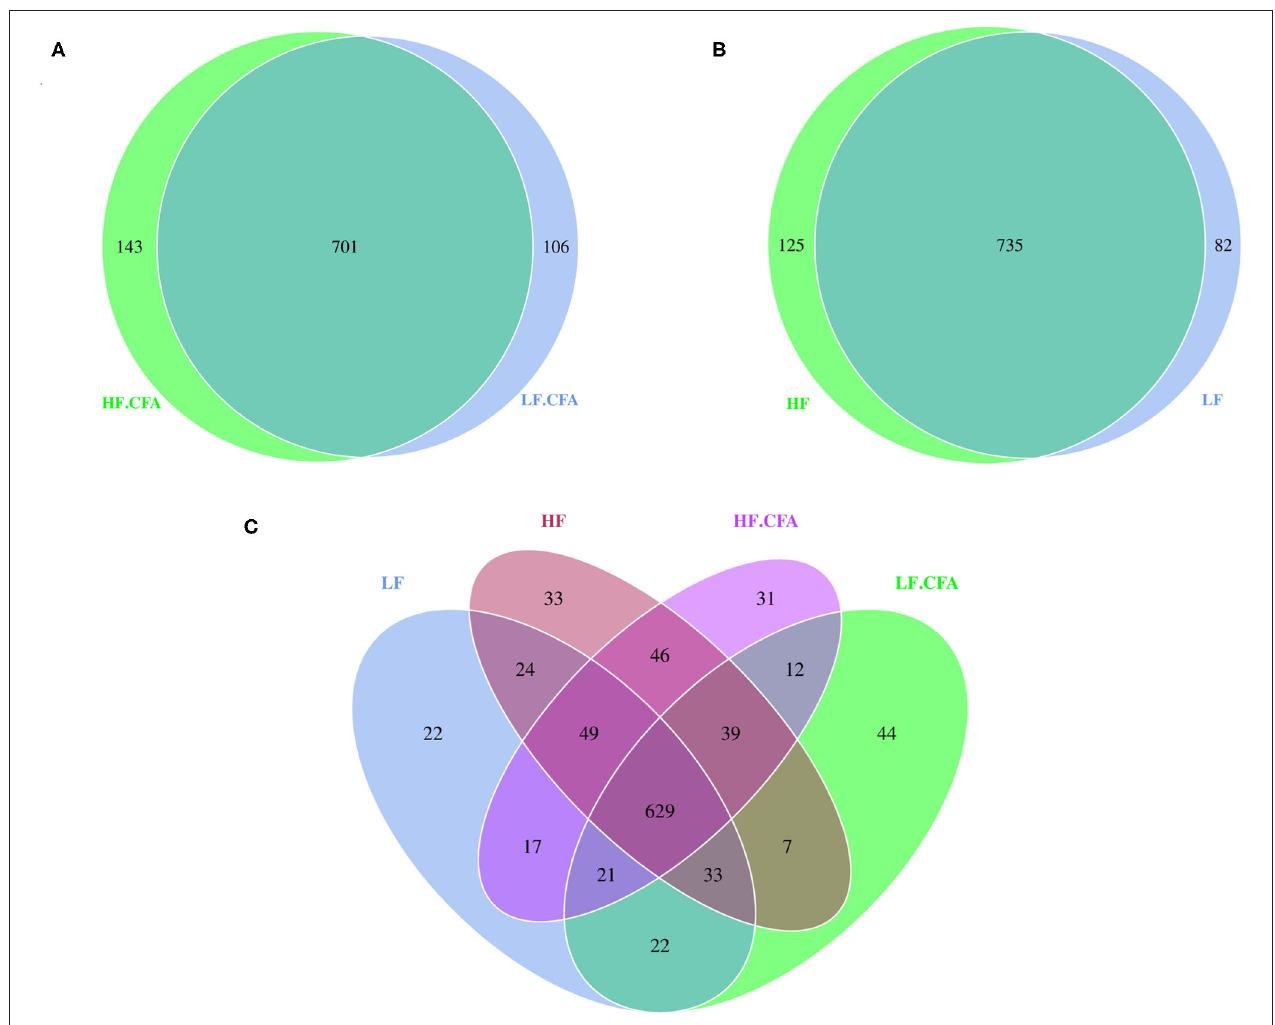
FIGURE 4 | Microbiota comparison of the OTUs among treatments in the colon. The observed OTUs sharing ≥ 97% sequence similarity. (A–C) Venn diagrams describe the common and unique OTUs among four groups, respectively, HF, High fiber, no CFA; LF, Low fiber, no CFA; HF.CFA, High fiber with CFA challenge; LF.CFA, Low fiber with CFA